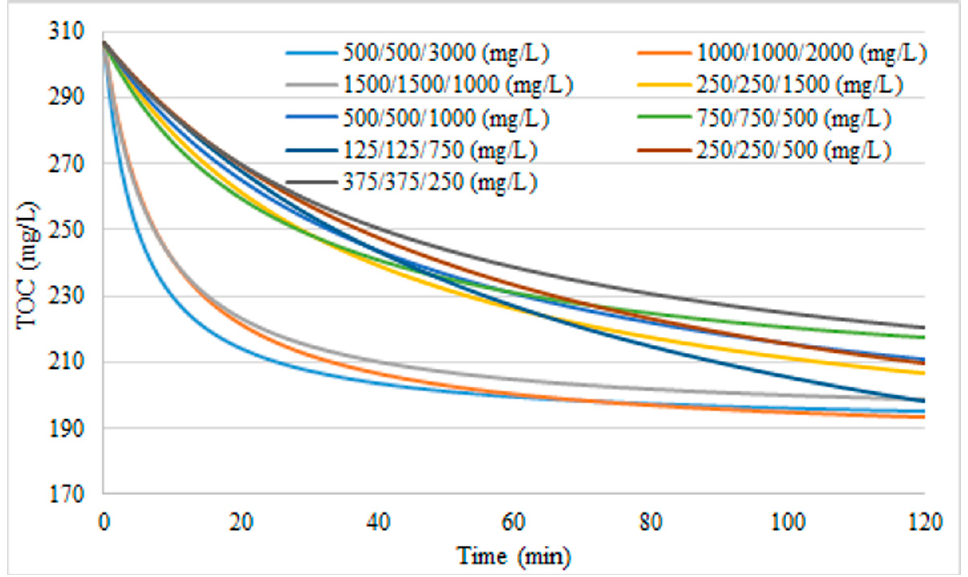
Figure 5. CW treatment results with different Fe 3 O 4 /Fe 2 O 3 /Fe 0 doses (mg/L) H 2 O 2 /COD mass ratio 2:1, UV irradiation, pH = 3.0.